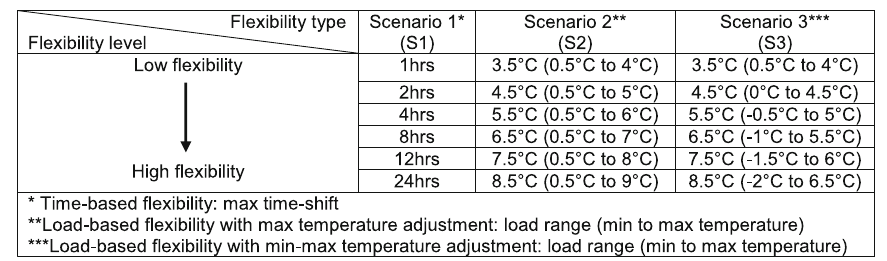
Table 2 Flexibility parameters used in different model